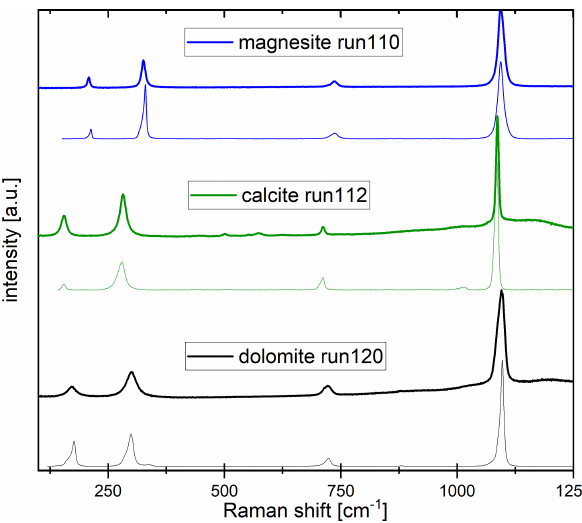
Figure 3. Raman spectra (bold lines) of unoriented magnesite (run 110), calcite (run 112) and dolomite (run 120) displayed together with RRUFF reference spectra (thin lines; https://rruff.info/, last ac- cess: November 2020) of magnesite (R040114), calcite (R040170) and dolomite (R050357),